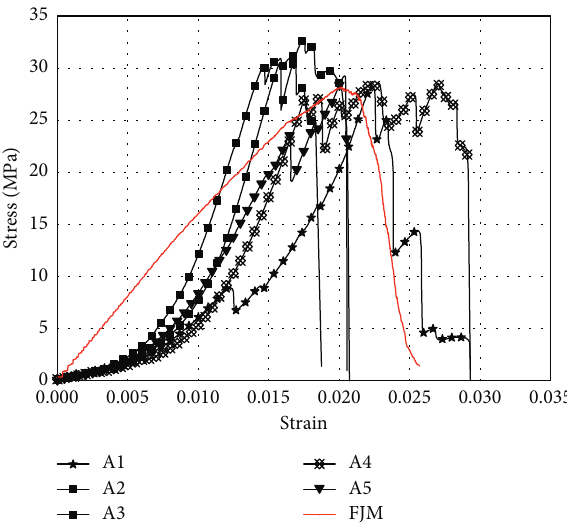
Figure 13: Stress-strain curves obtained from experimental and numerical simulations.